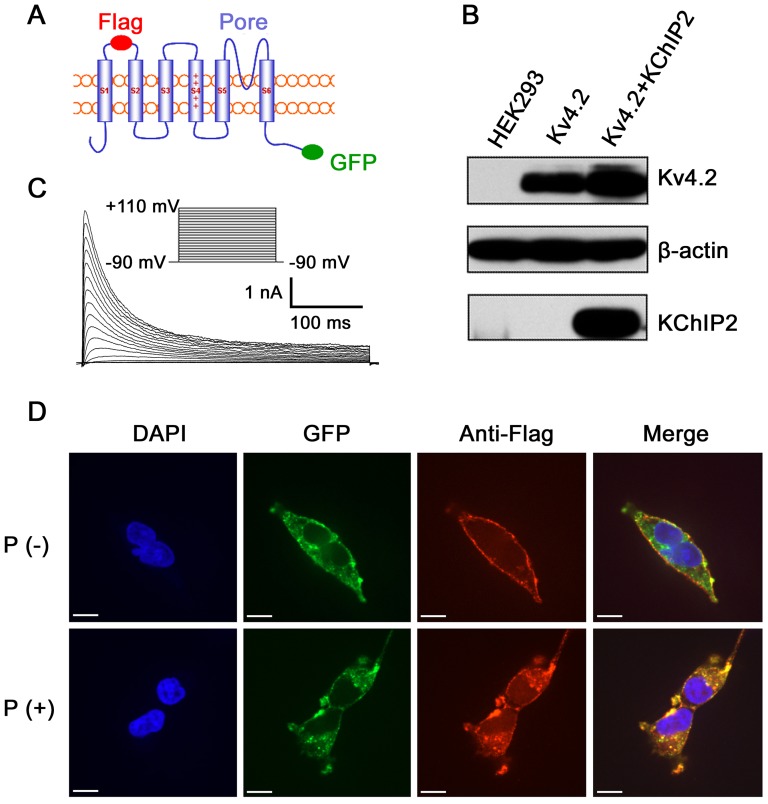
The expression of Kv4.2 and KChIP2 in HEK293 cells.
A, diagram for Flag-Kv4.2-GFP oriented in the plasma membrane. Flag and GFP were tagged in the extracellular S1-S2 loop and the C-terminal, respectively. B, Western blotting analysis of HEK293 cells expressing Kv4.2 with or without the expression of KChIP2. The plasmids transfected in HEK293 cells were indicated above each lane. The detecting antibodies were indicated at the right side. Lane 1 showed the lysate from cells expressing the corresponding vector as control. Lane 2 and 3 represented cells expressing Kv4.2 alone or with KChIP2, respectively. C, an example of I
Kv4.2 recorded in HEK293 cells expressing Flag-Kv4.2-GFP. No significant difference of I
Kv4.2 was found between Flag-Kv4.2-GFP-expressing cells and cells expressing untagged Kv4.2 (not shown). D, confocal images of HEK293 cells transfected with Flag-Kv4.2-GFP, showing subcellular localization of Kv4.2, with (P (+)) or without (P (−)) membrane permeabilization. The surface population of Kv4.2 was visualized by anti-Flag antibody (red) and the whole Kv4.2 was indicated by GFP (green). The nuclei were stained by diamidino-phenyl-indole (DAPI) (blue). Note that anti-Flag antibody detected only the membranous Kv4.2 when without permeabilization, while it detected the overall Kv4.2 after permeabilization. The merged images showed perfect co-localization of Flag-Kv4.2-GFP detected by anti-Flag antibody and GFP, respectively. Scale bars  =  50 µm.